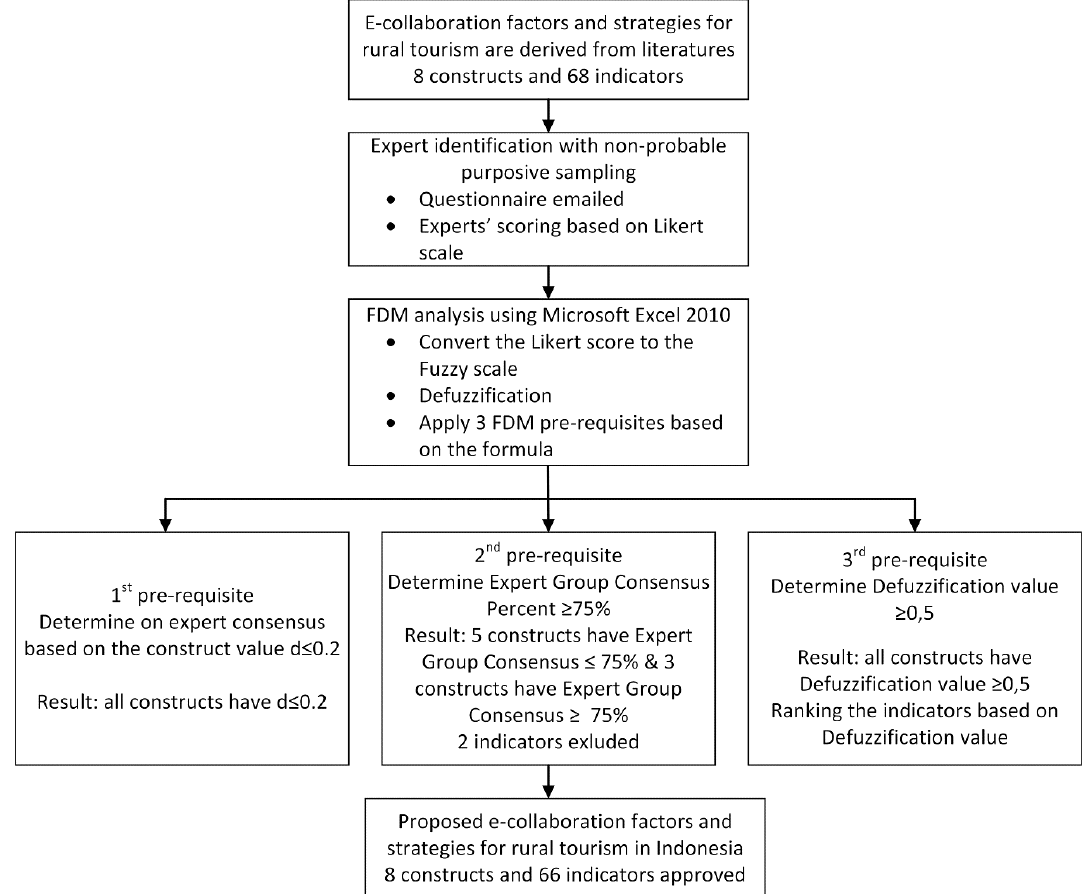
Figure 4. Summary of Fuzzy Delphi Method Phase.